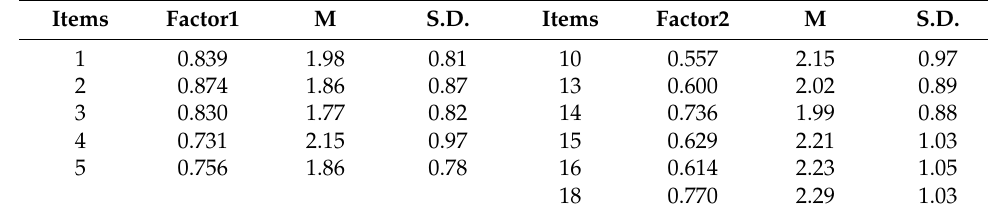
Table 2. Factor loadings for the scale.